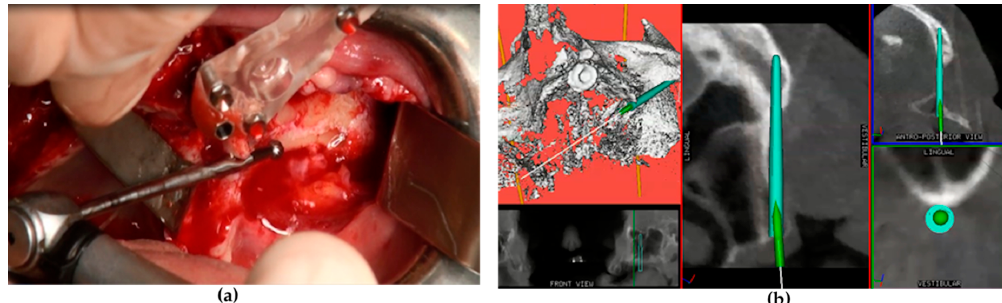
Figure 1. Implant site preparation with the drill mounted on the angled handpiece ( a ) and real-time tracking of the drill via the navigation system screen ( b ).